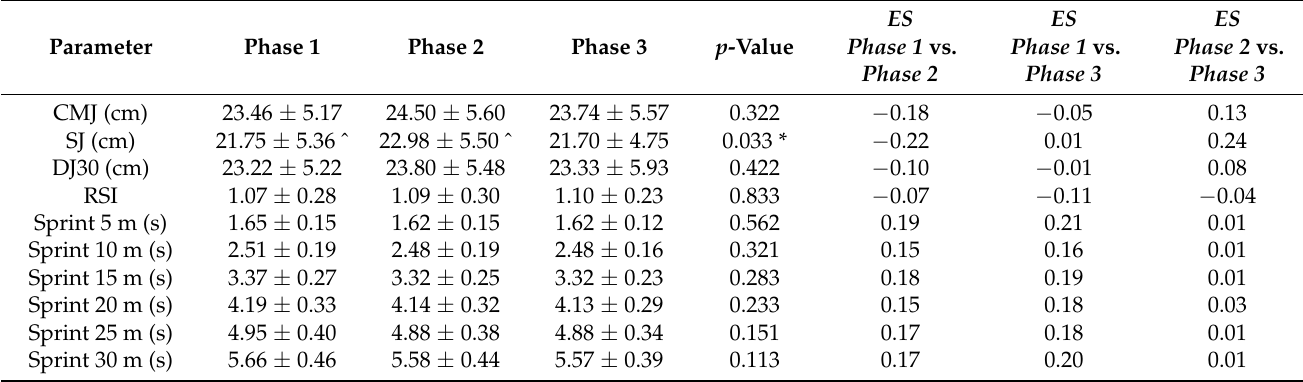
The CMJ F-v relationship parameters at the three different phases of the MC are indicated in the Table 2. No significant differences ( p ≥ 0.327, ES < 0.45) were found